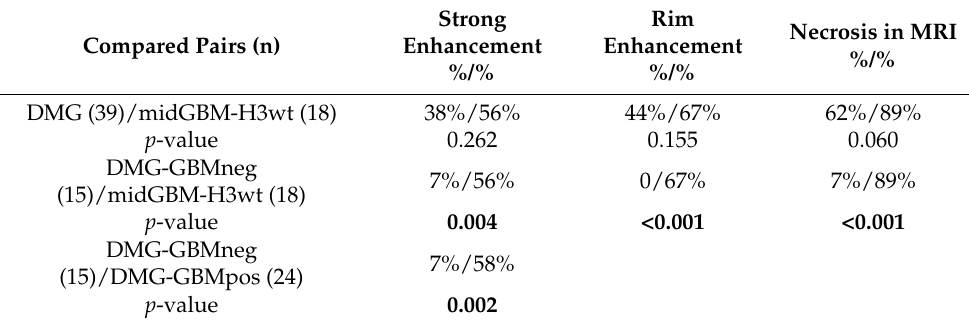
Table 5. Comparison of different tumor groups in terms of strong enhancement, rim enhancement and necrosis in MRI considering histological features of malignancy (microvascular proliferations, microscopic